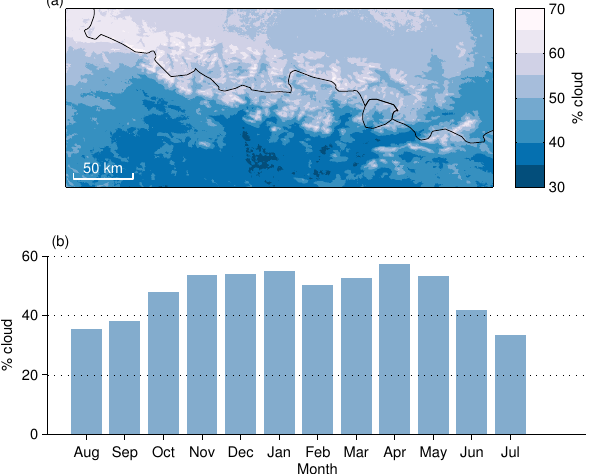
Figure 11. Mean snow cover duration in the Pyrenees over 2000– 2013 for different elevation bands. The snow cover duration is the number of days with snow in our gap-filled product. It was com- puted with the same elevation bands as in Fig. 1, except for 3200– 3400ma . s . l . (only four pixels at the MODIS resolution). Otherwise the fractional areas of each elevation band in the study domain are 53% (10–800), 31% (800–1600), 13% (1600–2400), and 2.5%